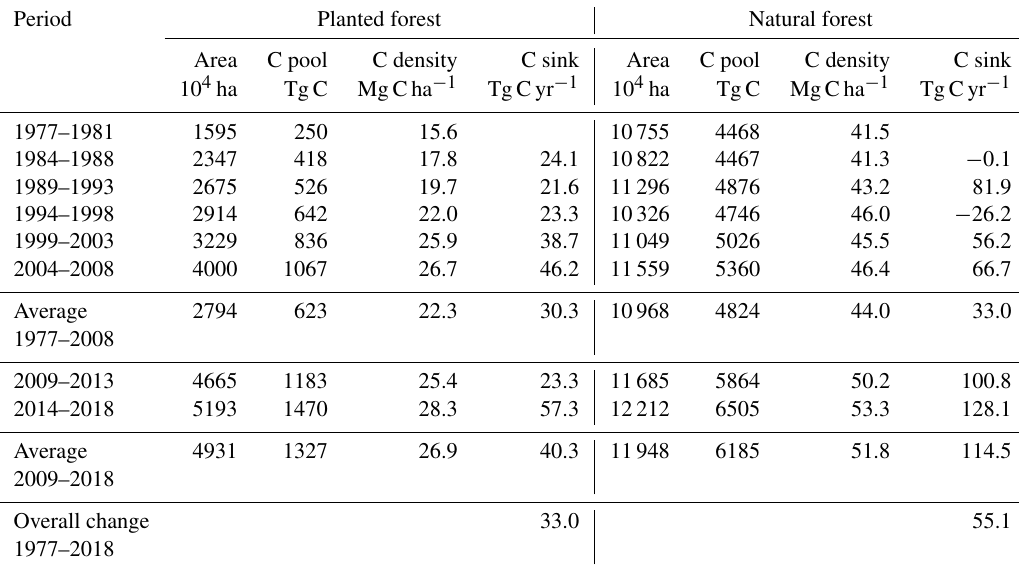
Table 2. Area, biomass C pool, C density, and C sink of planted and natural forests. Period Planted forest Natural forest